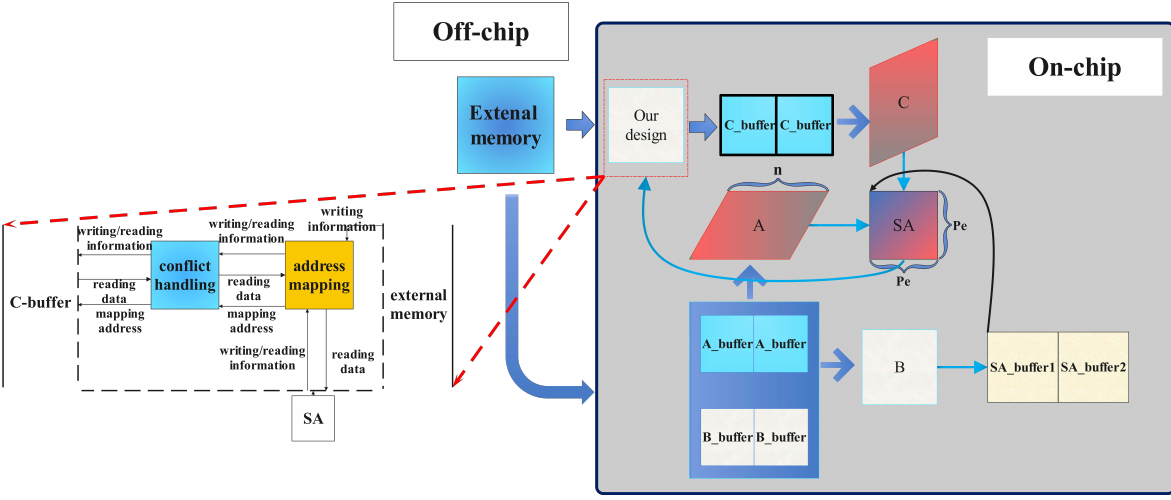
Figure 7. The architecture